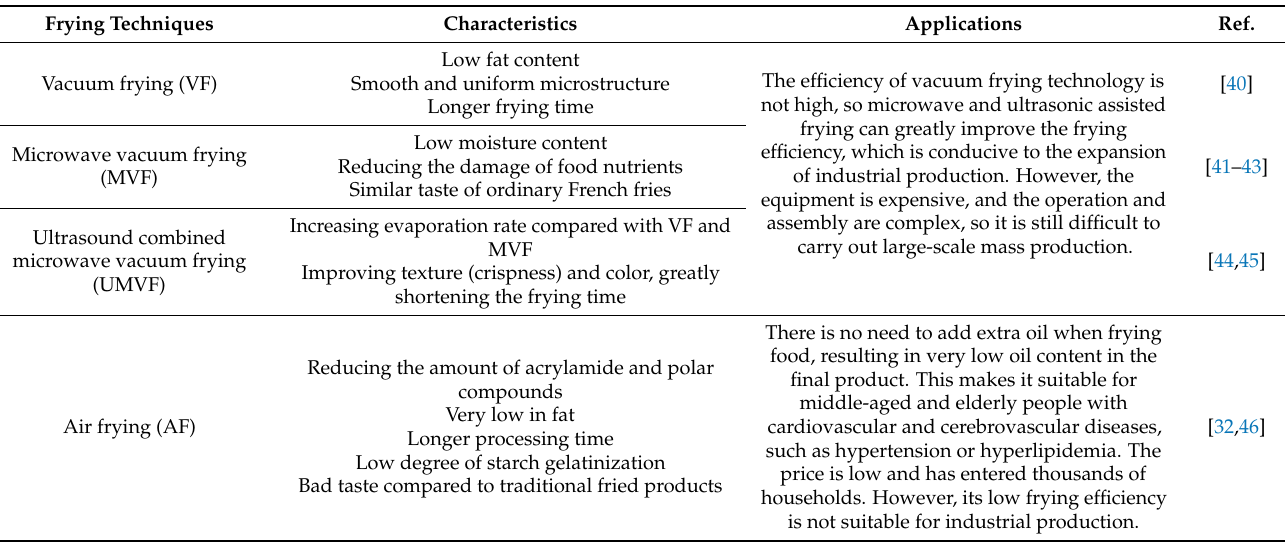
Table 2. Brief on new frying